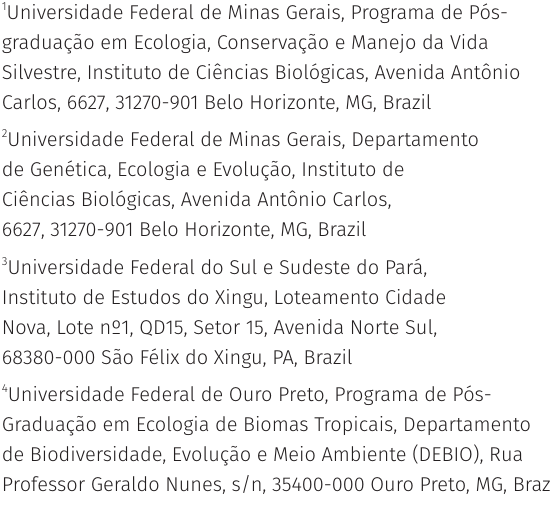
Table SI. The 145 publications selected to assess the Cerrado restoration panorama. Table SII. Steps of the selection of the plant species considered for the evaluation of how plant species have been used for ecological restoration in the Cerrado. When there was a thesis or dissertation that has been published as an article and the same plant species occurred in both publications, they were considered only one